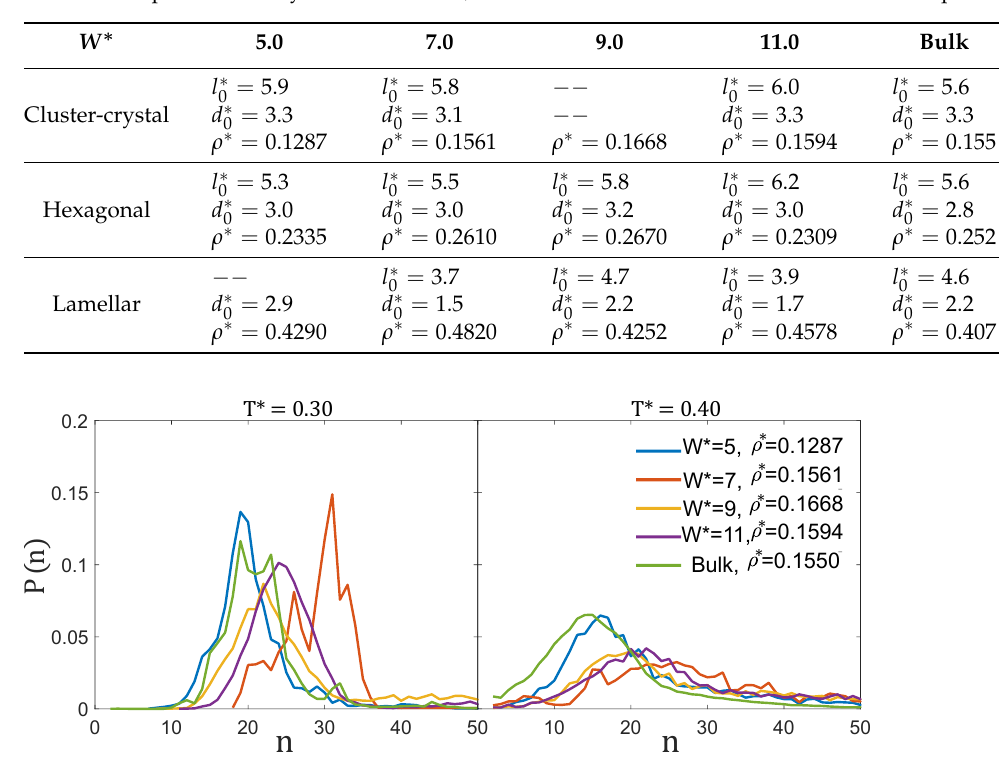
= l 0 / σ ) and the average cluster size 0 ∗ corresponds to the average cluster 0